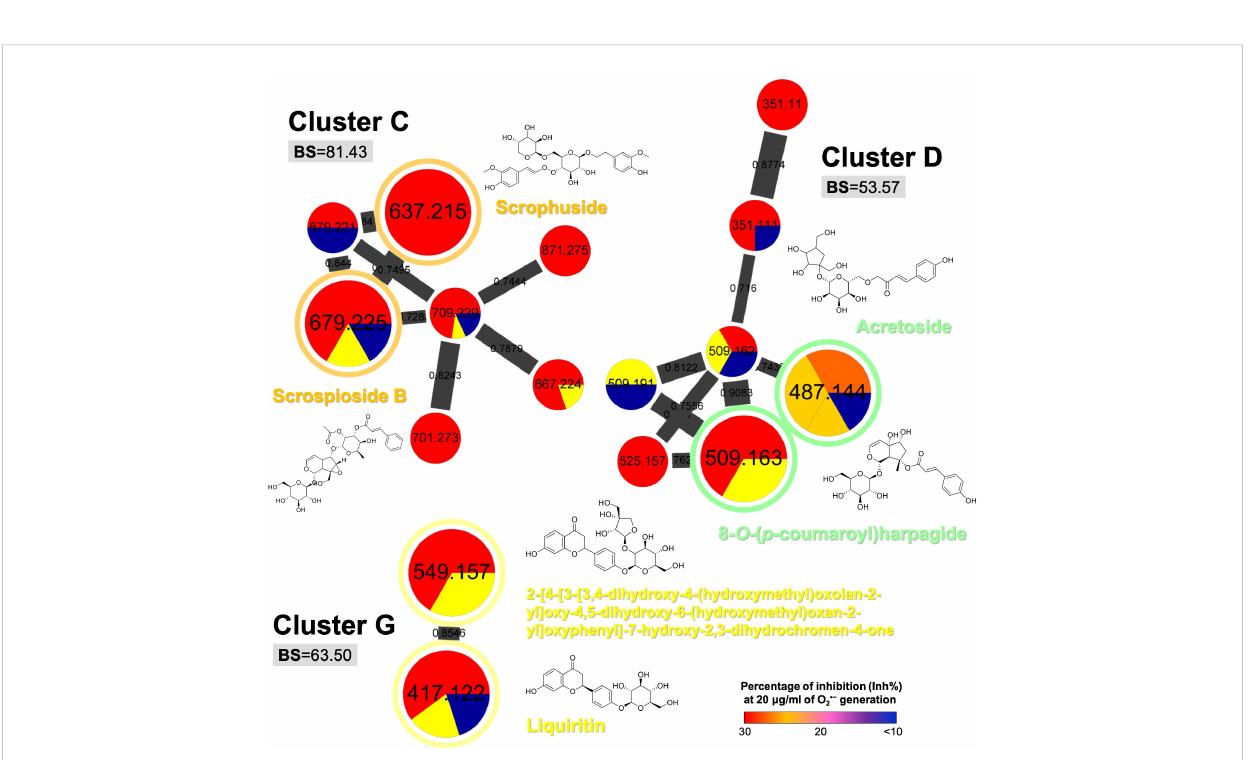
FIGURE 4 The selected MIMN clusters with high bioactive scores (BS ≥ 50) as potential anti-in fl ammatory chemical groups. The putative annotations were conducted based on the MS 2 matching from GNPS and Reaxys